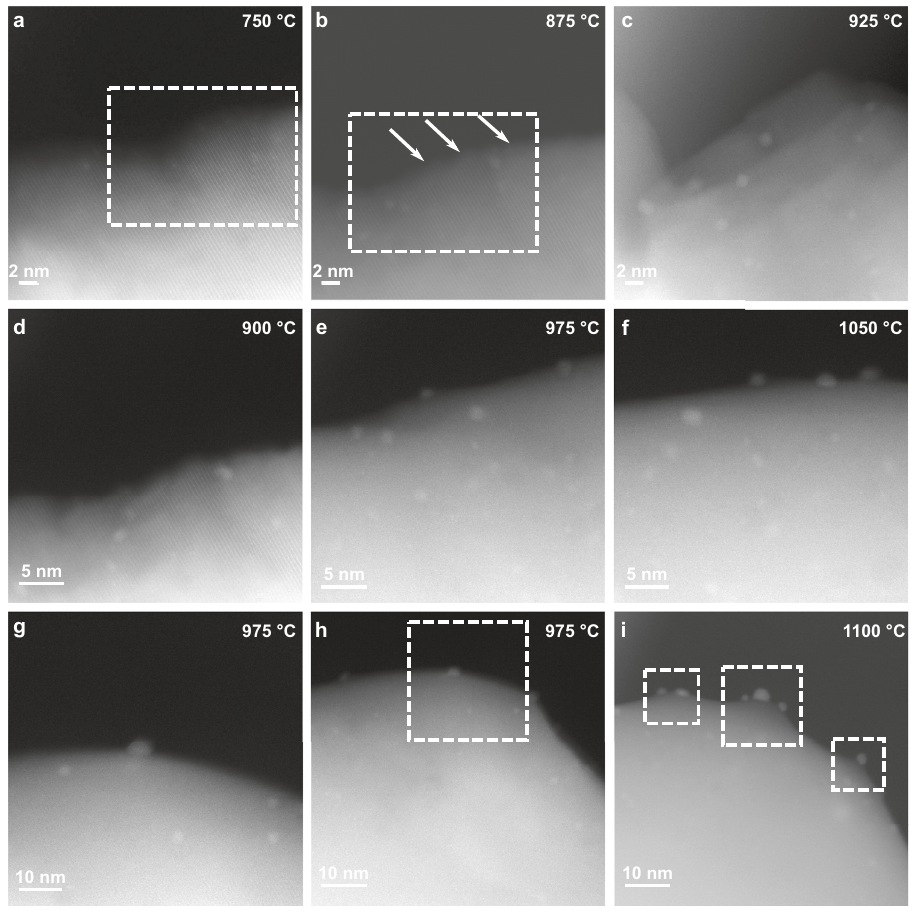
Fig. 6 | Morphology of the perovskite and socket evolution during in situ exsolution. a – c STEM micrographs showing crests formation during the in situ heating of a 0.5% Ir-doped STO grain. The rough surface visible at 750°C in the squaredregionin( a )evolvesintoamorede fi nedfacetedmorphologyat875°C( b ), as indicated by the arrows. Faceting of the sample surfaces becomes more pro- minent up to T=925°C ( c ). d – f The crests ’ surface evolves into a sintered-like